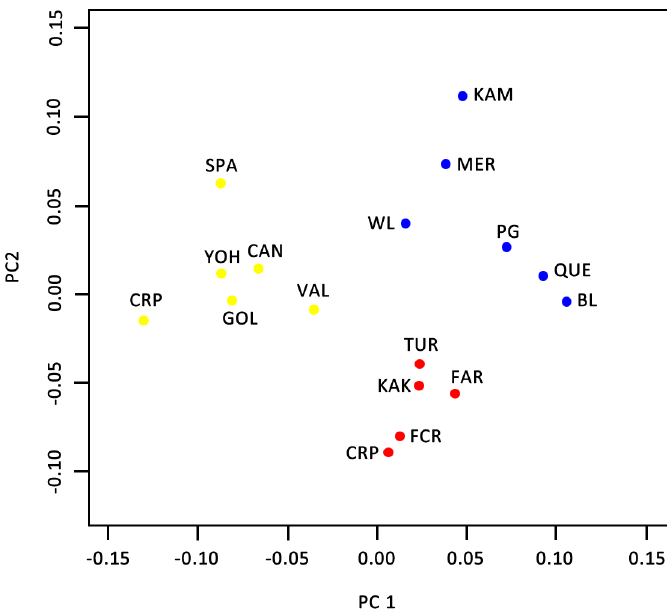
Figure 2. Principal Coordinates Analysis (PCoA) among 17 Leptographiumlongiclavatum populations based on Nei ’ s genetic distance using GenAlEx (cluster ‘‘BC’’ by blue, ‘‘North’’ by red, ‘‘Rocky’’ by yellow). The first and second accounted for 37% and 22.2% of the variance, respectively. doi:10.1371/journal.pone.0105455.g002 (Figure 1, S2, S3). STRUCTURE analysis inferred the existence of three clusters based on the Evanno method implemented in Structure Harvester (Figure 1, S2). The level of individual assignment and admixture was also explored and examined for K = 2 and K = 4 to ensure the optimal cluster K capture most of the biological/genetic characteristics of the population structure.